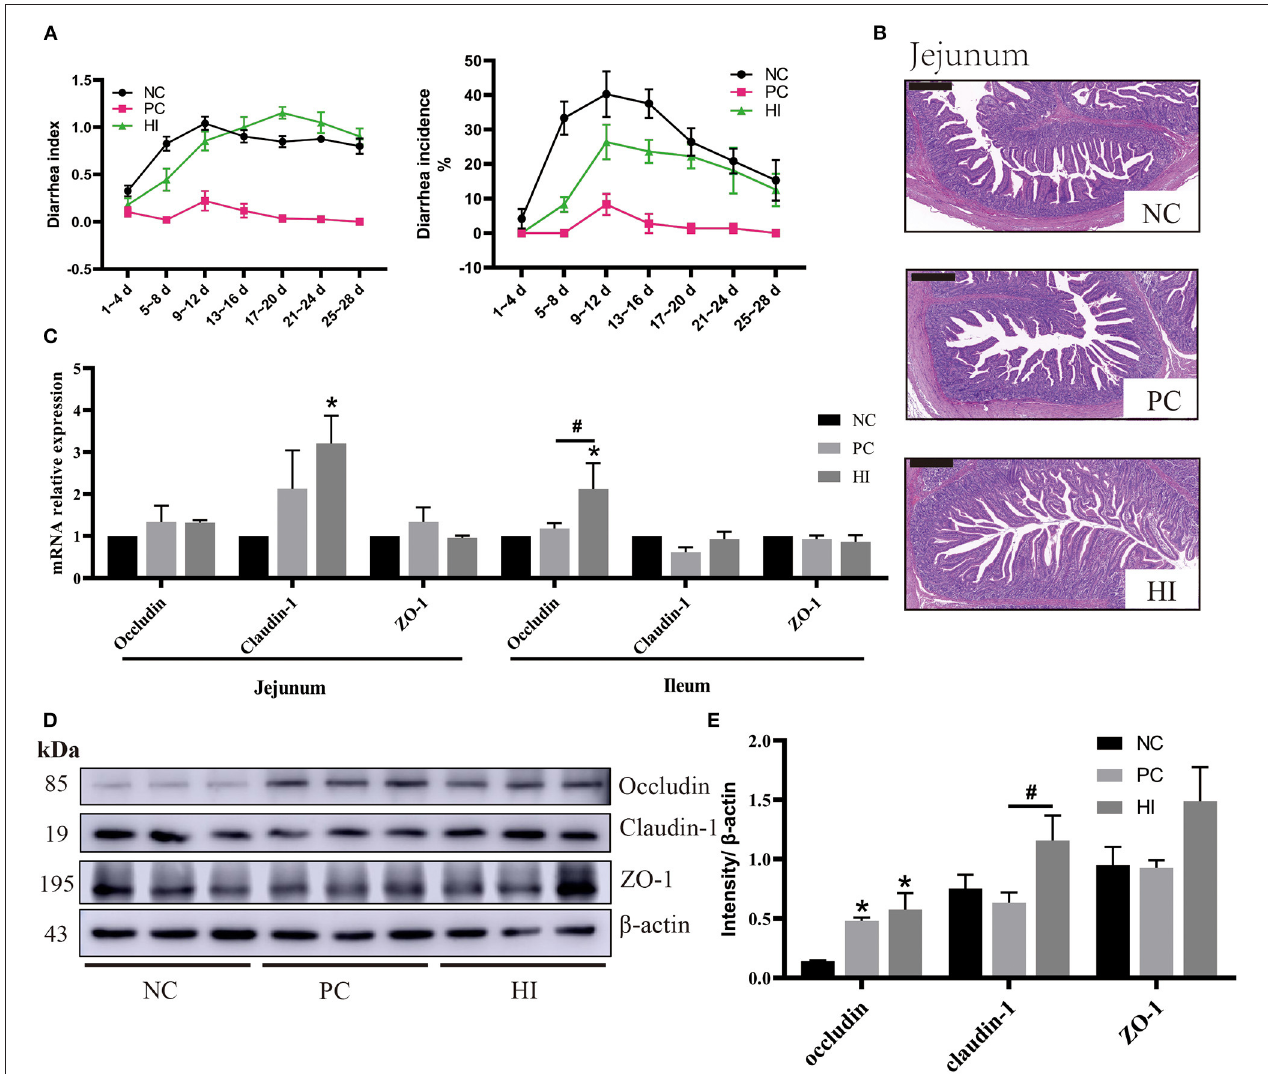
FIGURE 1 | Effect of dietary Hermetia illucens larvae on diarrhea incidence, intestinal morphology, and TJ protein expression in weaned pigs. (A) Diarrhea incidence and diarrhea index of weaned pigs. (B) Representative images of jejunal HE stains (scale bar, 500 µ m). (C) Relative mRNA expression levels of occludin , claudin-1 , and ZO-1 in the jejunum and ileum were determined using real-time PCR. (D) Relative protein expression levels of occludin, claudin-1, and ZO-1 in the ileum were measured using western blot. Densitometric values were normalized to those of β -actin. (E) Statistical analysis of the data in D. All data are expressed as the mean